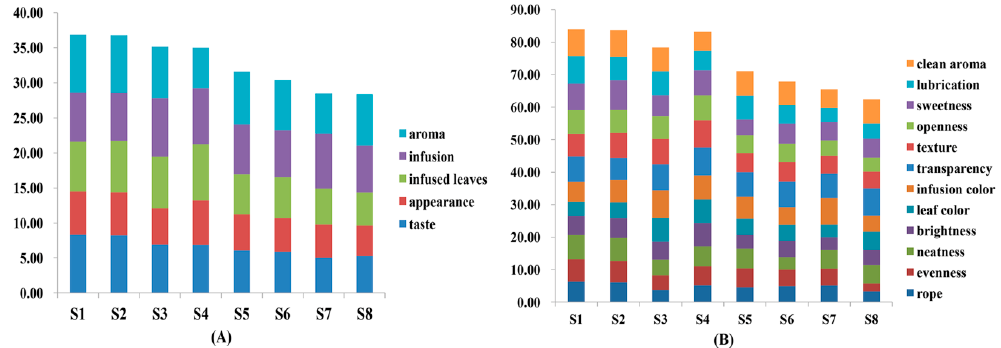
Figure 1. Histogram for the descriptive sensory analysis of Nü-Er-Cha: ( A ) The scores plot of five descriptors; ( B ) the scores plot of twelve indicators.